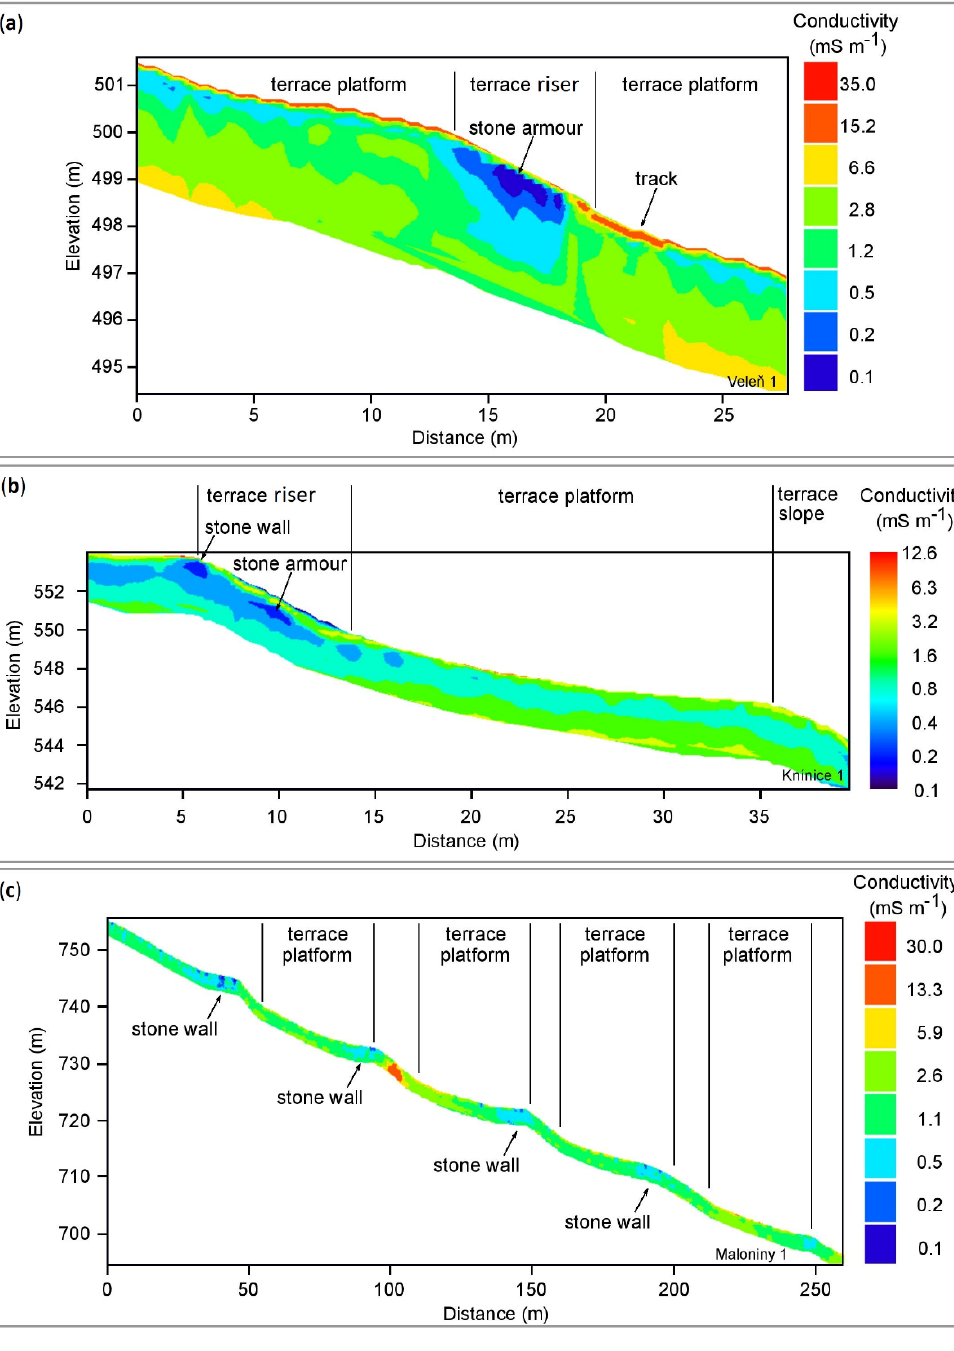
Figure 12. DEMP imaging of shallow subsurface at the three sites studied: ( a ) Velká Veleň, ( b ) Knínice, and ( c ) Maloniny. Note the varying resistivity scales in the panels. Less conductive (more resistive, depicted in blue shades) subsurface domains are interpreted as stone accumulations [data sources: field measurements in combination with GPS data processed in EM4Soil, EMTOMO, 2018].